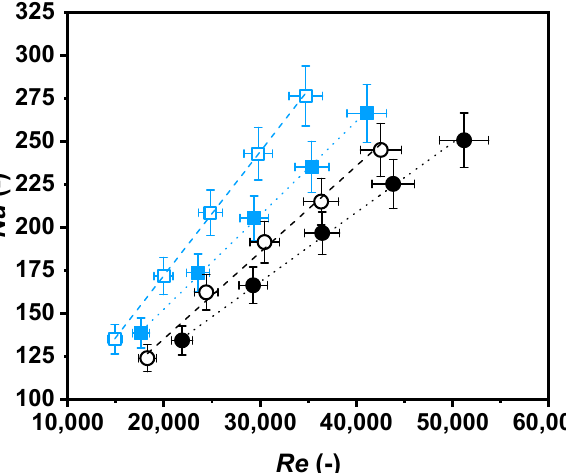
Figure 8. Nusselt number as a function of Reynolds number for water (black) and nanofluid (blue) at 308.15 K ( ○ , ☐ ) and 318.15 K ( ● , ■ ).